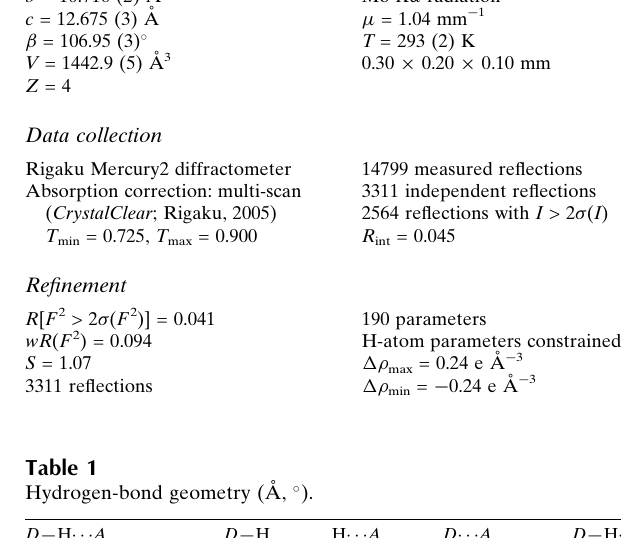
Rigaku Mercury2 diffractometer Absorption correction: multi-scan ( CrystalClear ; Rigaku, 2005) T min = 0.725, T max = 0.900